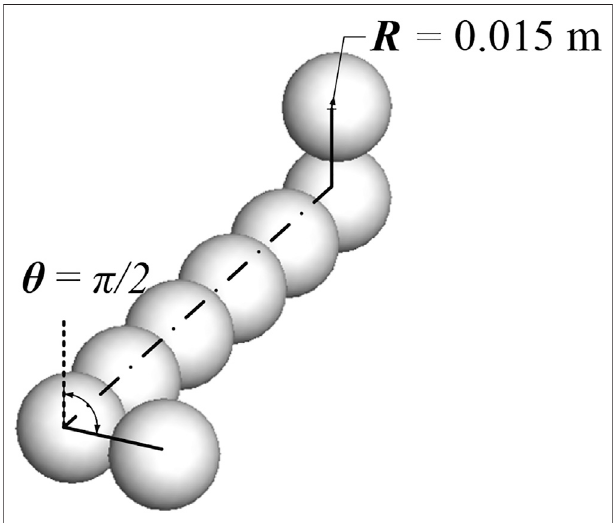
FIGURE 1 | Shape of particles with entangle angle θ (cid:1) π /2 of z-particles.